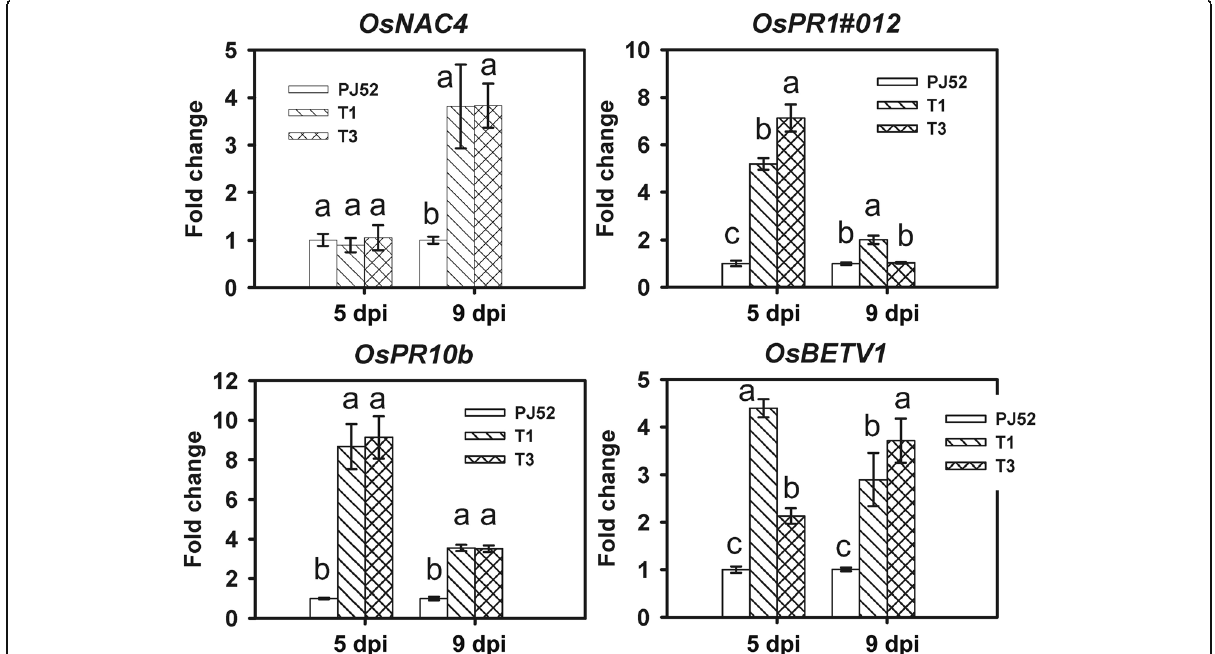
Fig. 6 Expression analysis of rice defense-related genes in response to infection of PJ52 and UV_1261 -silenced transformants. Rice spikelet samples inoculated with PJ52, T1, or T3 were collected at 5 and 9 dpi. Expression levels of OsNAC4 , OsPR1#012 , OsPR10b , and OsBETV1 were determined by RT-qPCR using rice OsUbi as the reference gene. Fold change was calculated by the comparative C T method 2 – ΔΔ CT using PJ52-inoculated samples as controls at indicated time points. Statistical analysis was performed with LSD method in SPSS Version 21. Different letters above the bars mean significant differences among datasets at each indicated time point ( P